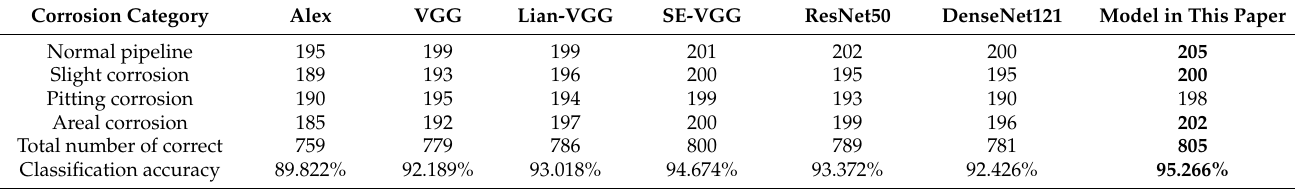
Table 3. Comparison of test classification results for the four types of pipe damage sample sets.